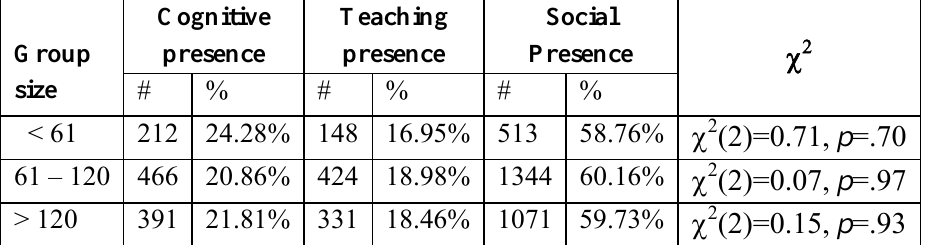
Differences between Observed Distributions by Group Size and Proposed Population Parameter Cognitive Group presence size